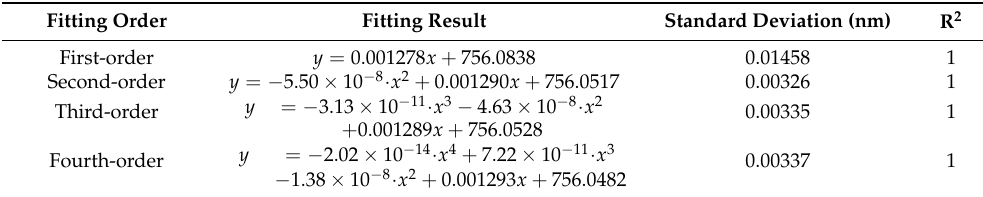
Table 10. Fitting results of the corresponding relationship between the center wavelength of the molecular oxygen A-band observation channel (channel 3) and the PBSC.